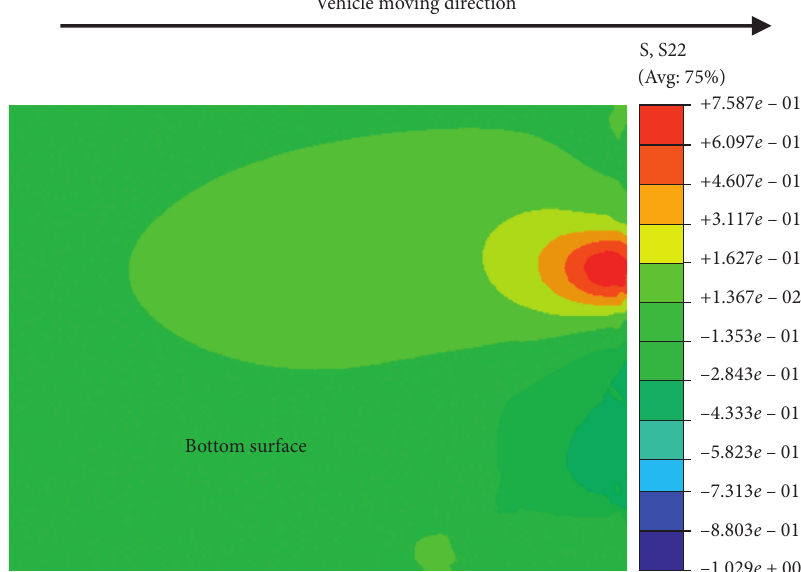
Figure 11: Tensile stress of the loaded slab with joint stiffness of 10q and void size of 1.2 m (slab bottom).